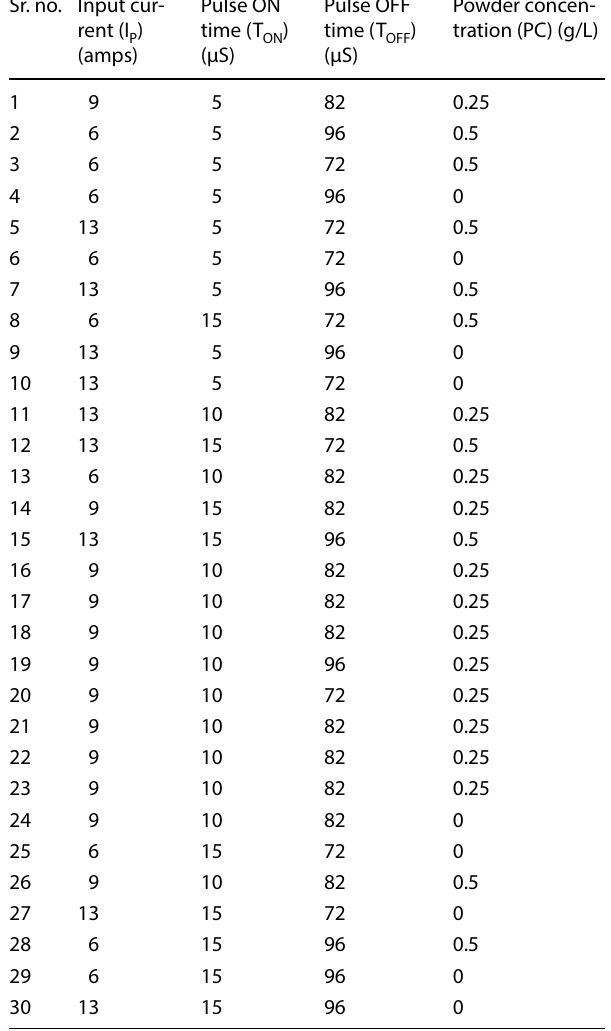
Table 4 Experimental design—PMEDM of Ti6Al4V Sr. no. Input cur- rent (I P